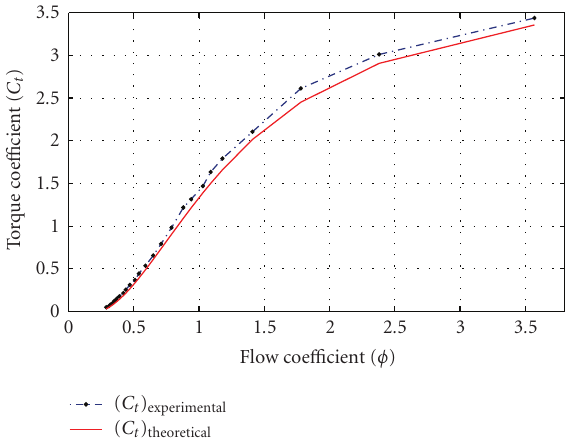
Figure 5: Turbine torque coe ffi cient versus flow coe ffi cient [10].